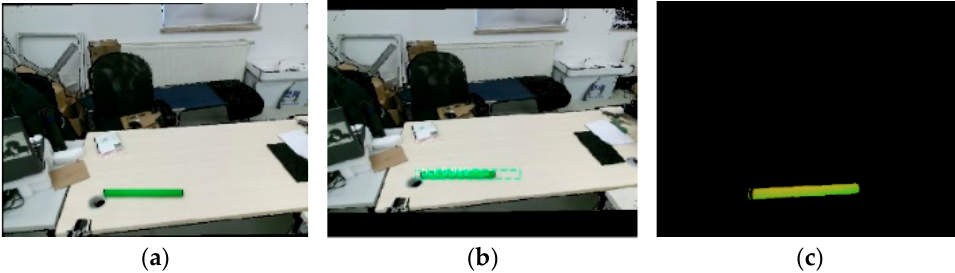
Figure 11. Schematic diagram of identification result. ( a ) The image was taken by the camera. ( b ) The identification result of Mask-RCNN algorithm. ( c ) The result of color threshold segmentation.